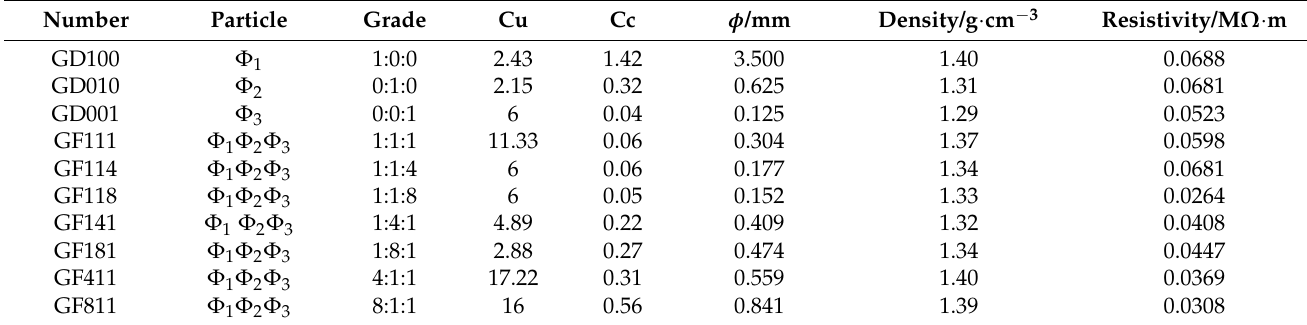
Table 2. Physical parameters of different particle tectonic coal